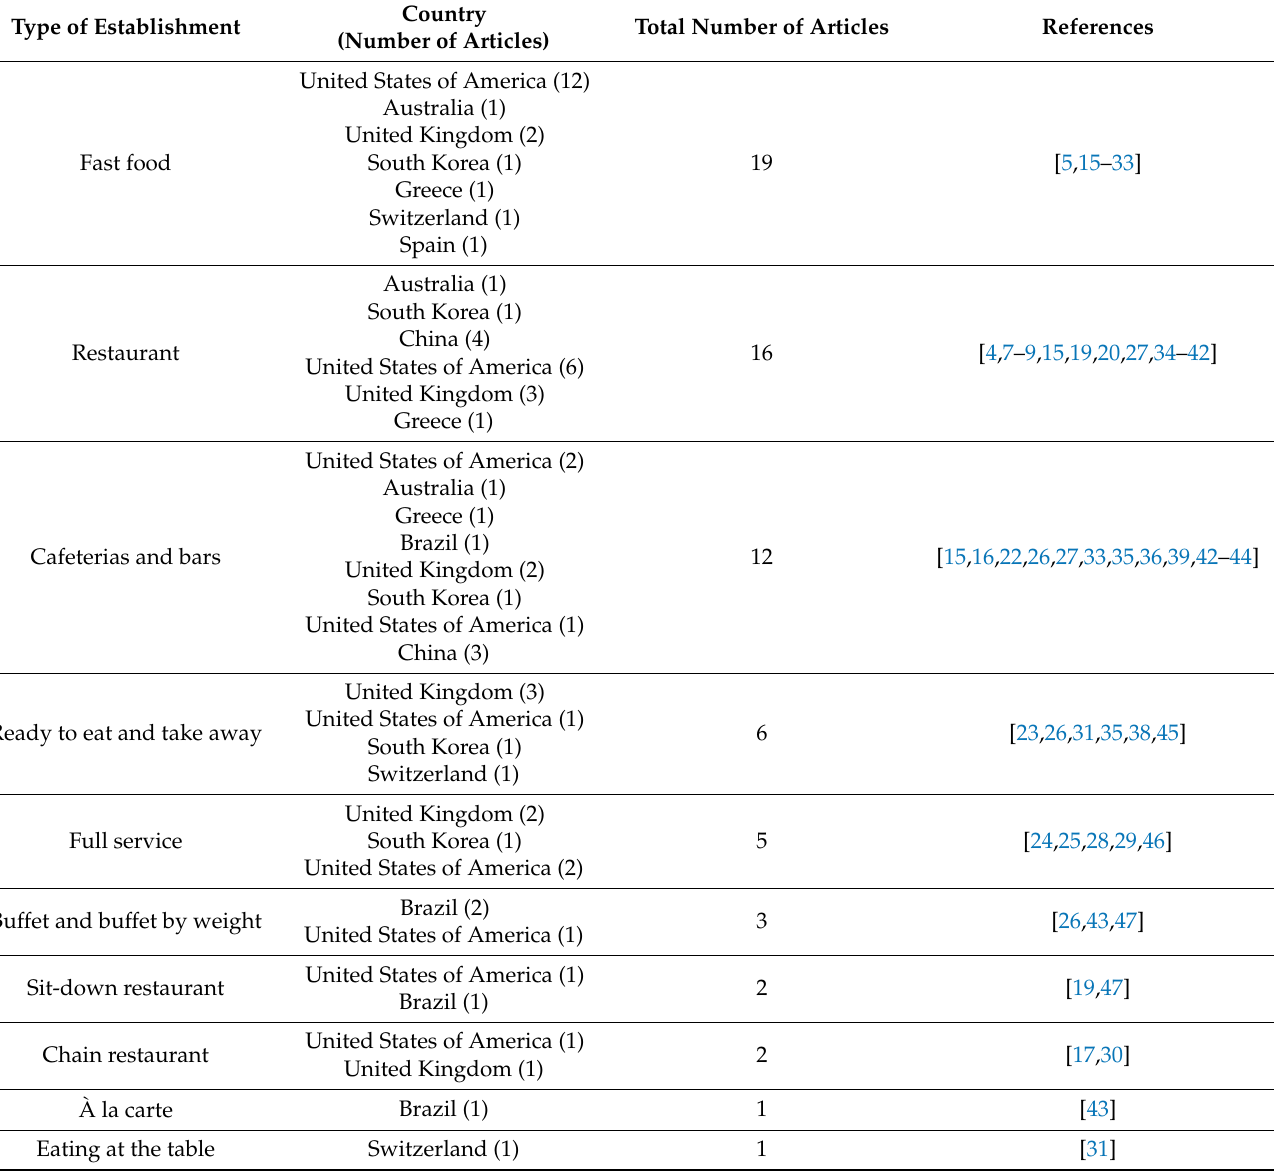
Table 2. Grouping of eating out of home by type of establishment and country.